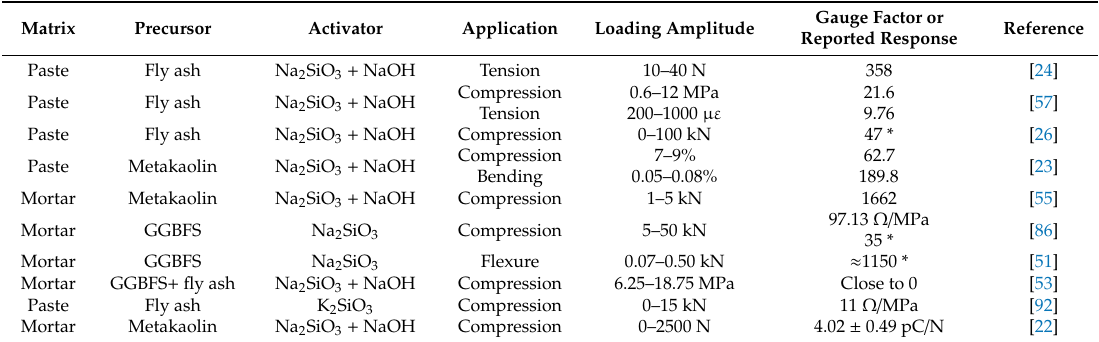
Table 4. Strain sensing performance of AAM with no conductive filler. Notations- sodium